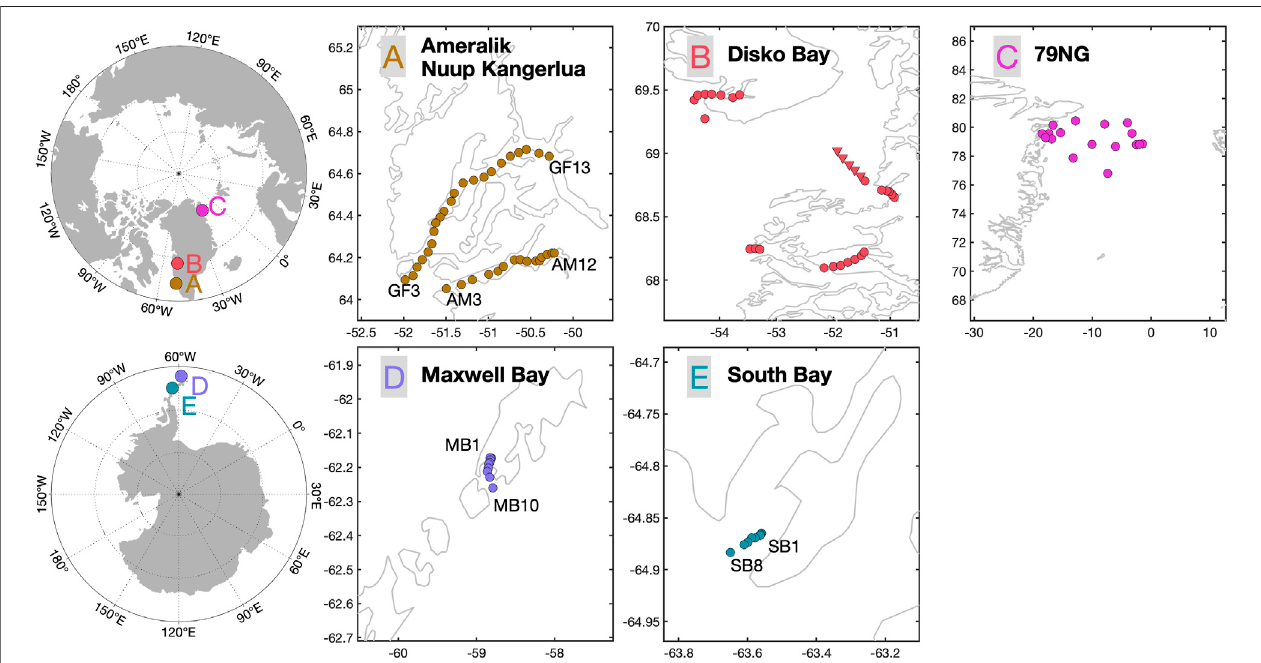
FIGURE 1 | Field locations and sample collection points. For consistency with prior and future work, the sample location labels in Nuup Kangerlua (also known as Godthåbsfjord), Ameralik, Maxwell Bay and South Bay (GF x , AM x , MB x and SB x respectively) refer to standard locations regularly visited by the ongoing long-term GreenlandEcosystemMonitoring(GEM,2021)andCentrodeInvestigaciónDinámicadeEcosistemasMarinosdeAltasLatitudes(IDEAL)projects.Inadditiontothefjord stations (red circles) sampled in three Disko Bay fjords [ (B) , clockwise from NW: Disko Island, Qasigiannguit, and Kangaatsiaq], a series of mid-Bay samples were also collected [ (B) , red triangles]. Nioghalvfjerdsbrae [ (C) , the 79 ° North Glacier], is referred to throughout as “ 79NG ” .